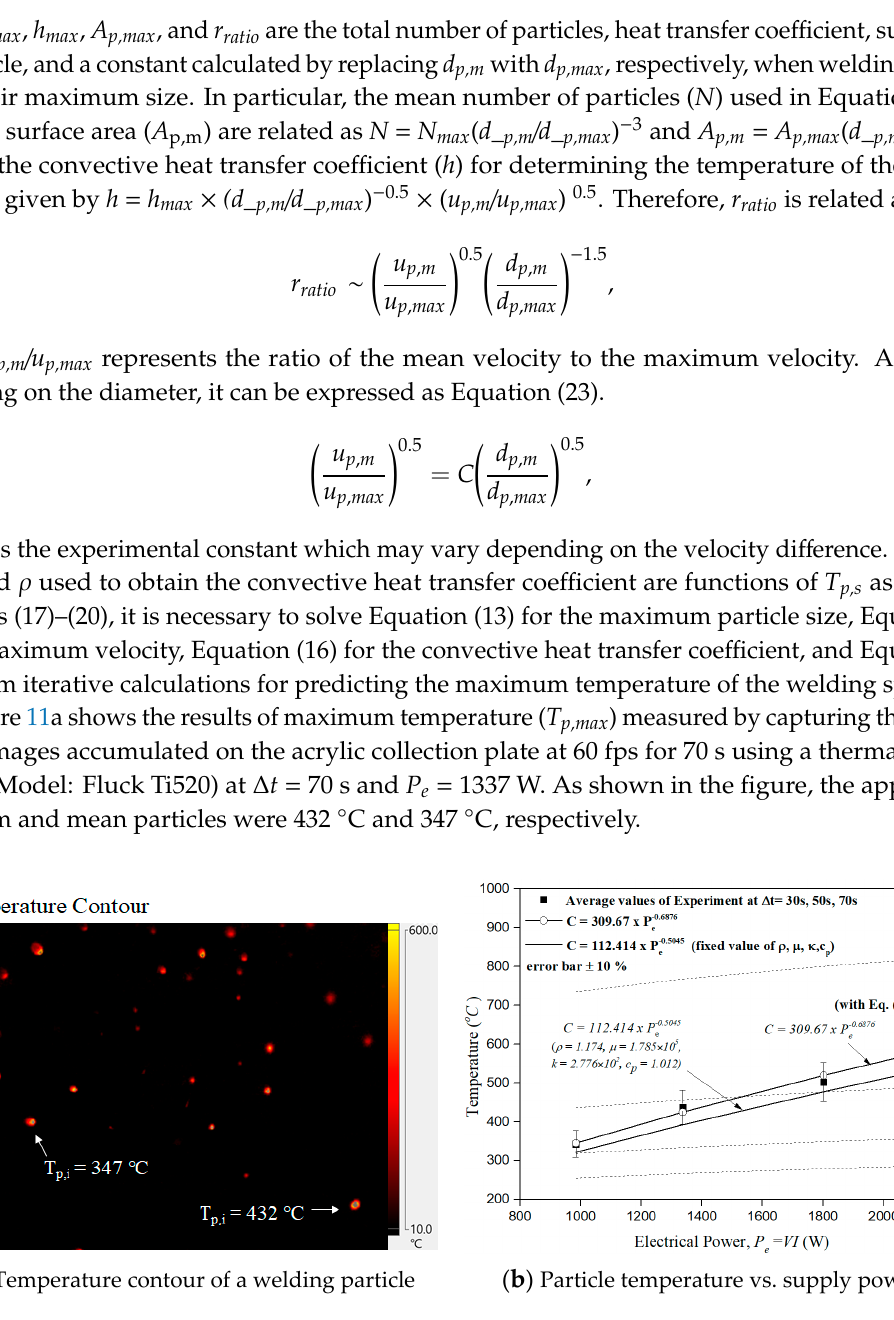
Figure 11. The results of temperature contour and the comparison of the prediction with experiment values of C .